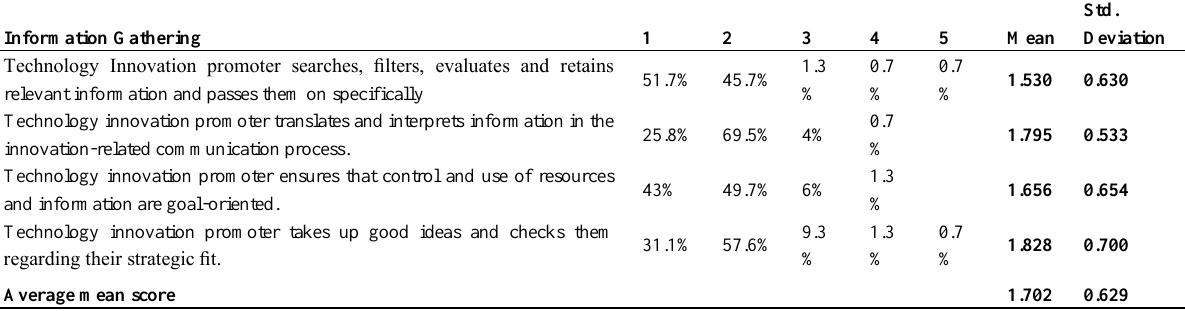
Table 3: Information Gathering Descriptive statistics